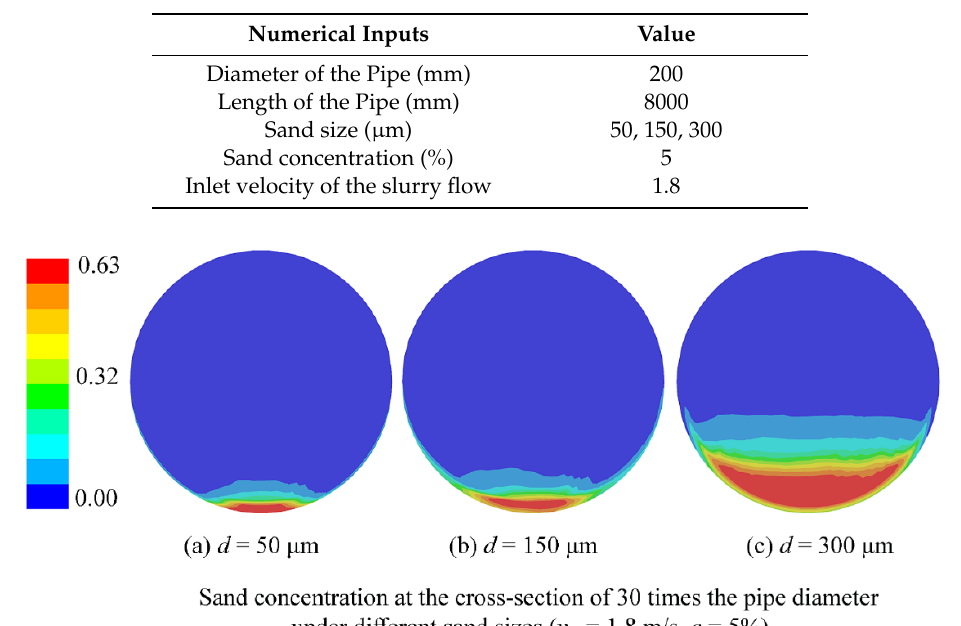
condition of di ff erent particle sizes. condition of different particle sizes. Table 4. Detailed inputs for the numerical simulation of sand transport and deposition under the condition of different particle sizes.